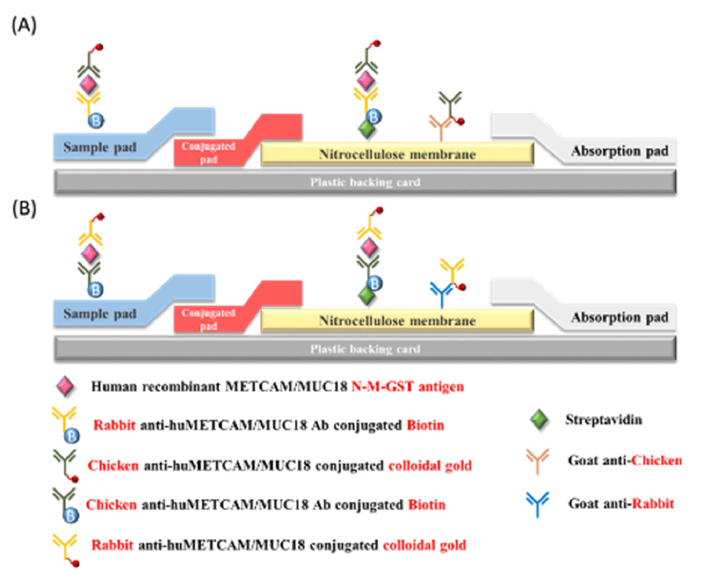
Figure 6. The procedure of the modified LFIA [44,45]. ( A ) indicates the antibody combination of biotinylated rabbit antibody and the nano ‐ gold ‐ conjugated chicken antibody. ( B ) indicates the antibody combination of biotinylated chicken antibody and the nano ‐ gold ‐ conjugated rabbit antibody.